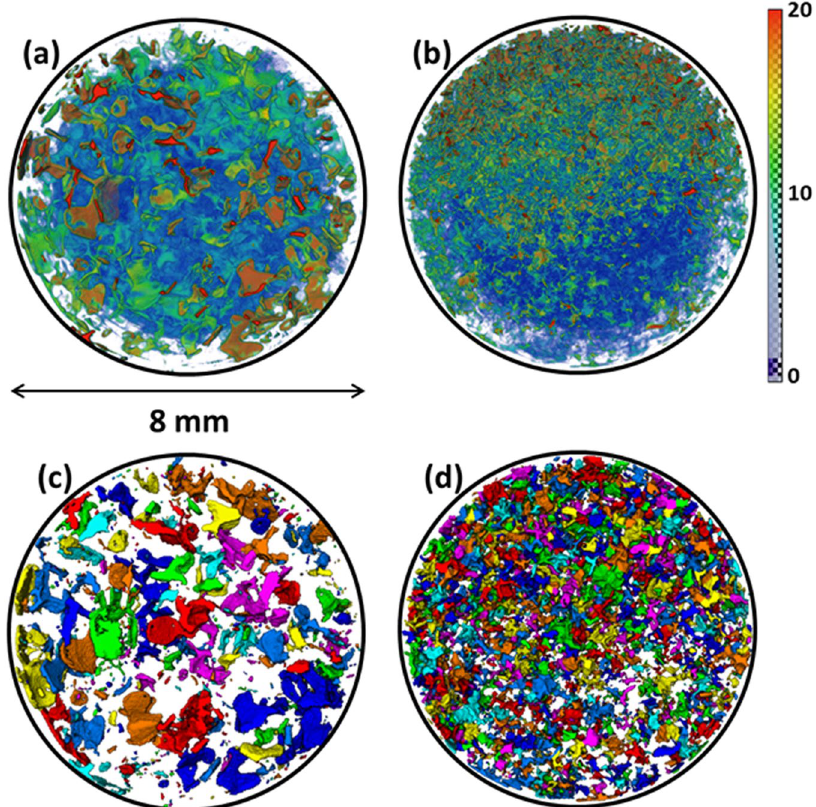
Figure 3. Distribution of solute concentration within the top 1 mm of ( a ) coarse- and ( b ) fine-textured sands 6 hours after the onset of the experiments. The colour map represents the solute concentration percentage, such that the closer to red, the higher the concentration. Also presented in ( c ) and ( d ) are the liquid cluster distributions within the top 1 mm of the fine- and coarse-grained sands. The clusters are defined as the liquid within pore bodies separated through pore throats. The colour represents the size of